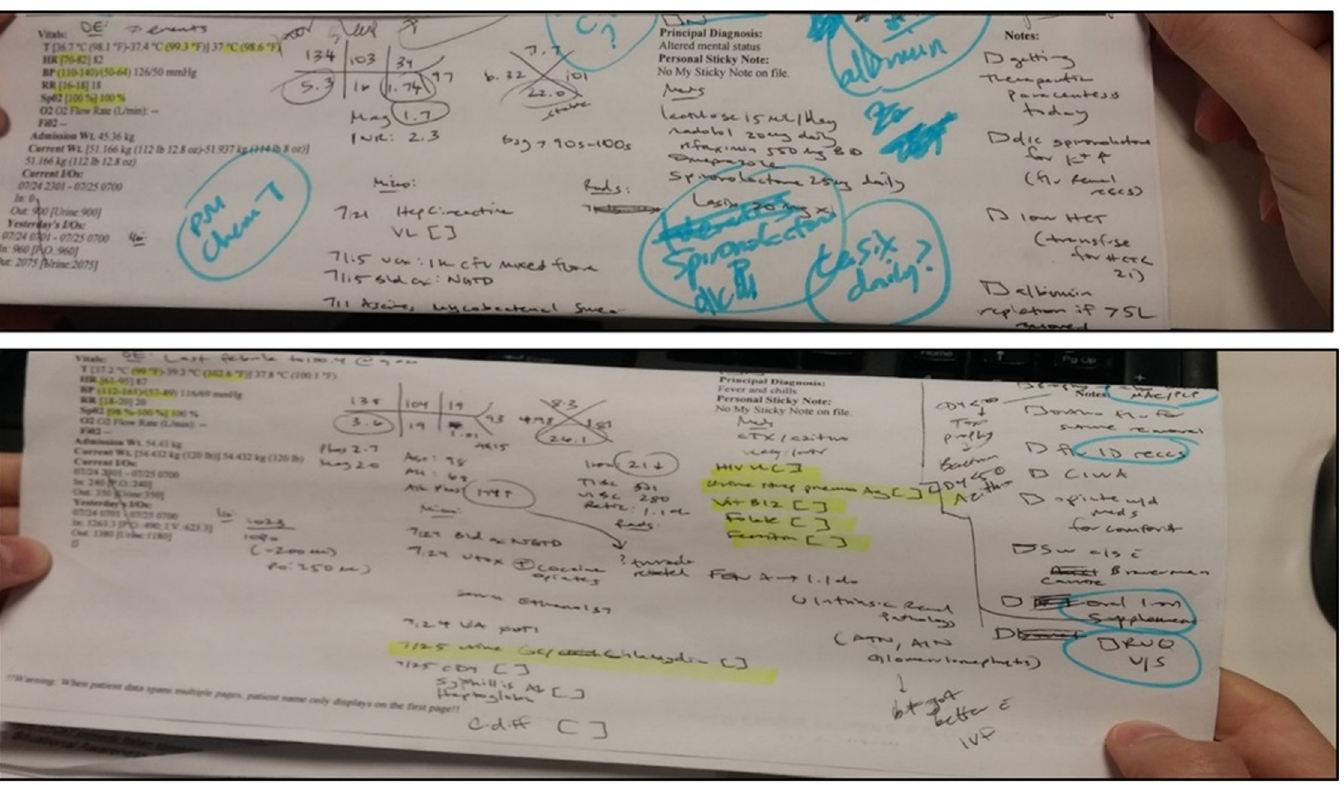
Fig 2. Use of handwriting on patient summary report during